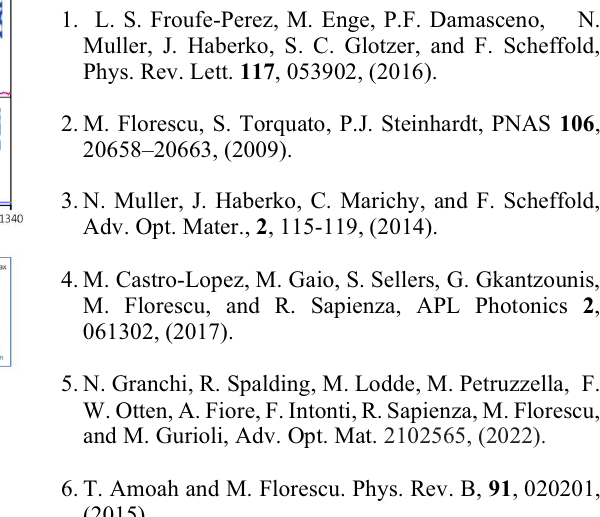
Fig. 1. (a) Design of the engineered defect in a HuD pattern and sketch of the SNOM probe used in illumination-collection configuration. (b) Bottom panel: SNOM PL spectrum acquired on the engineered defect displaying four modes D (dipole-like), Q (quadrupole-like), H (hexapole-like) and O (octupole-like). Upper panel: SNOM PL spectrum acquired on the accidental four-fold defect, called topological T. (c) SNOM PL map centered around 1326 nm, corresponding to mode H, whose FEM map of the electric field intensity is shown in the inset. (d) SNOM PL map centered amount 1339 nm, corresponding to the hyperuniform topological four-fold defect. The inset reports the relative FEM electric field intensity